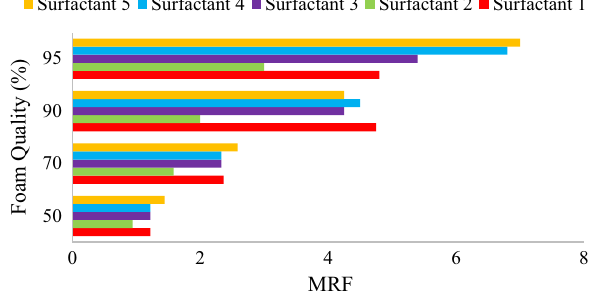
Fig. 8 Pressure drops across microfluidic chip when CO with brine and surfactant solutions at different oil fractions, and at 100 °C